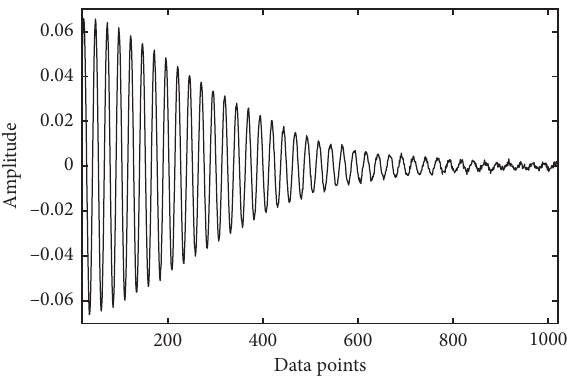
Figure 9: A two-DOF system with base random excitation.